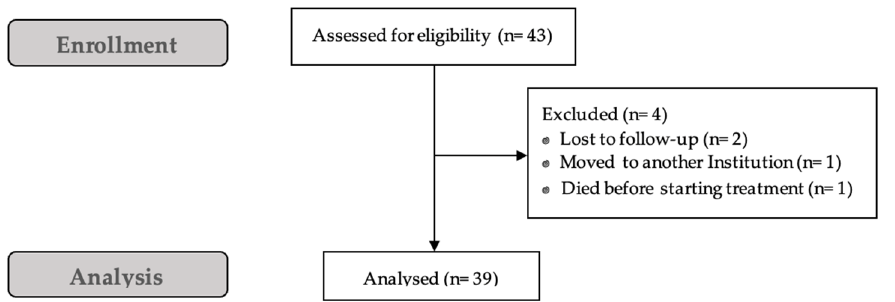
Figure 1. Kaplan–Meier Curve of progression-free survival.